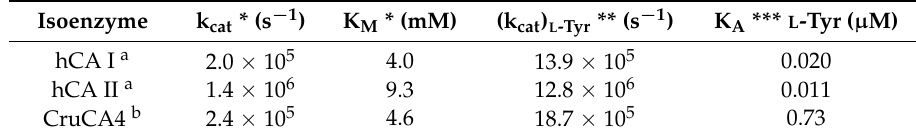
Table 2. Activation of human carbonic anhydrase (hCA) isozymes I, II, and CruCA4 with L -Tyr, at 25 °C, for the CO 2 hydration reaction.